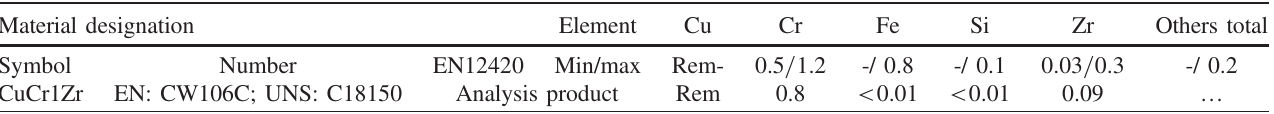
TABLE I. CuCr1Zr chemical composition [wt %] and material designation according to EN 12420 and product analysis. Material designation